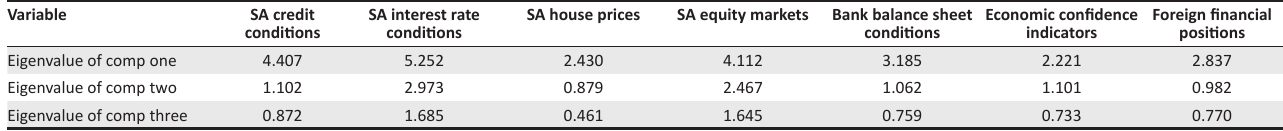
TABLE 3-A1: Component eigenvalue.